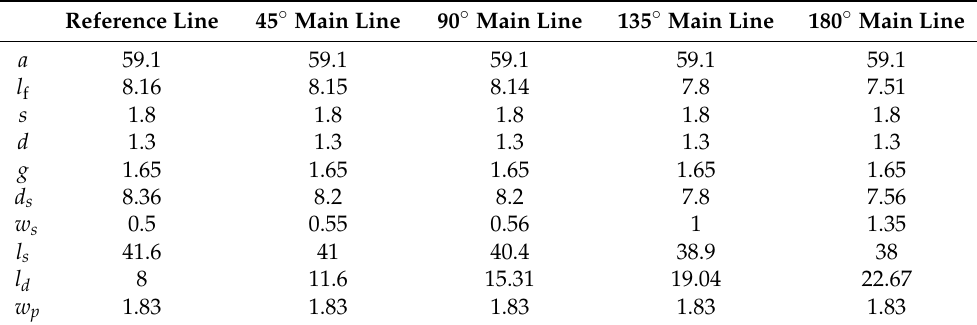
Table 1. Dimensions of the proposed balanced SIW phase shifter (Unit: mm).